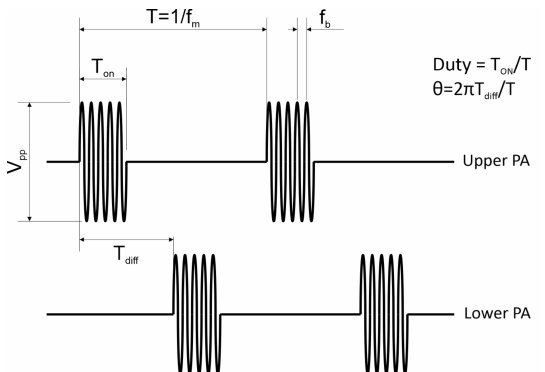
Figure 6. High-voltage high-frequency pulse-width modulation sinusoidal Wave. The signal is amplified by the high voltage plasma power supply. Whereas: Vpp —peak to peak voltage, T ON —ON time of plasma actuator, T —time per phase, Duty —Duty of the PWN signal, f b —base frequency generated by the plasma power supply, f m —modular frequency, T dif f —Time difference between the upper PA and lower PA signal, θ —Phase difference between the upper PA and lower PA signal.